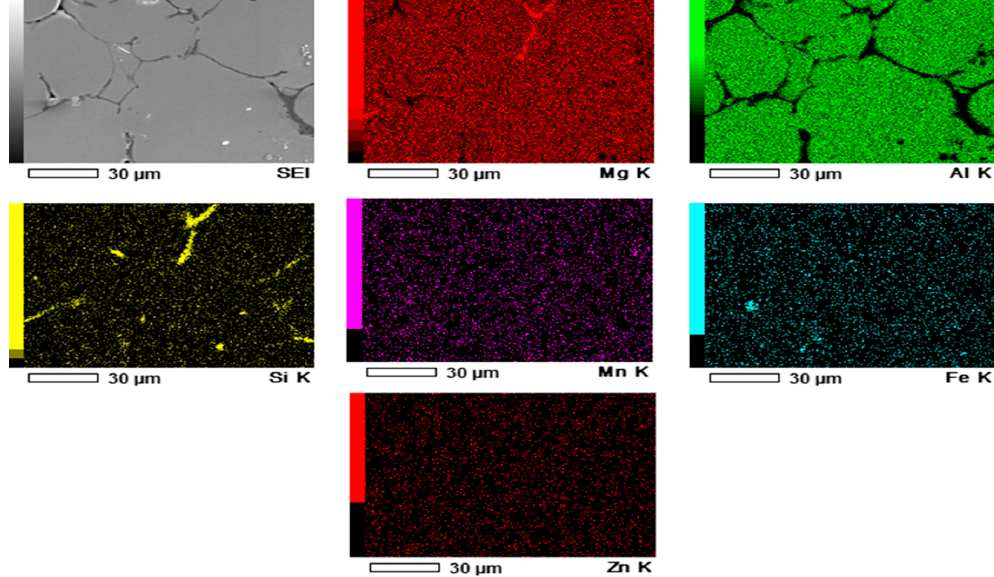
Figure 8. SEM-EDS mapping of secondary phases after homogenization.